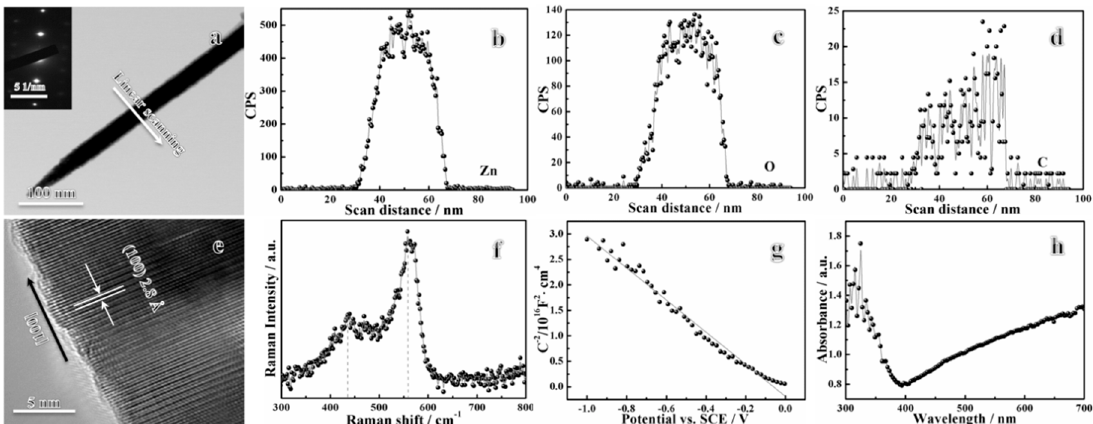
Figure 2. Transmission electron microscopy (TEM) image ( a ), selected-area electron diffraction (SAED) pattern (inset image of figure a ), EDXS line-scan profiles ( b ) Zn, ( c ) O and ( d ) C, and high-resolution transmission electron microscopy (HRTEM) image ( e ) of single ZnO nanowire, Raman spectrum ( f ), Mott–Schottky plot ( g ) as well as UV-visible absorption spectrum ( h ) of ZnO nanowire film. The arrows in figure 2a and e indicate the line-scan direction of EDXS and the preferred growth orientation of single ZnO nanowire, respectively.